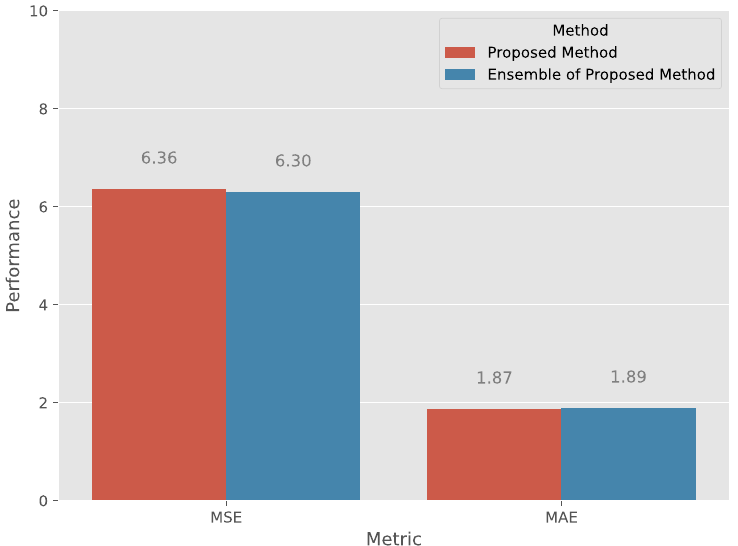
Figure 7. Single fusion network vs. ensemble of fusion network, where a lower value is